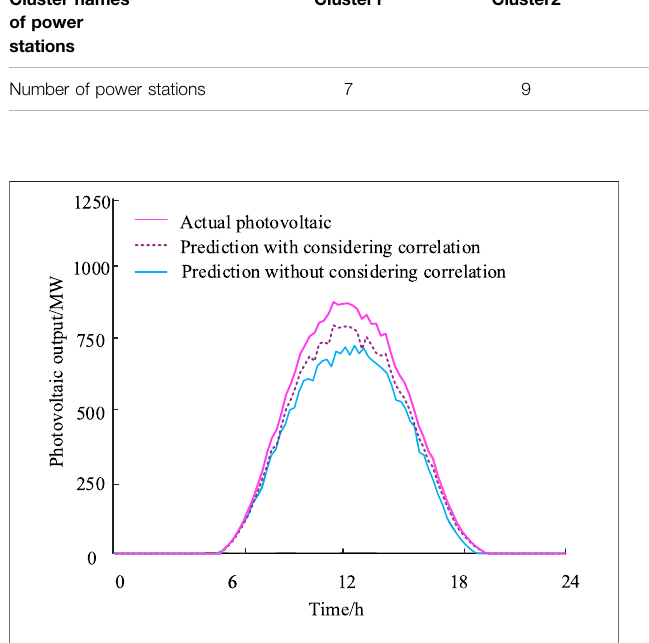
TABLE 2 | Number of power stations corresponding to 6 cluster power stations in QingHai province. Cluster names of power